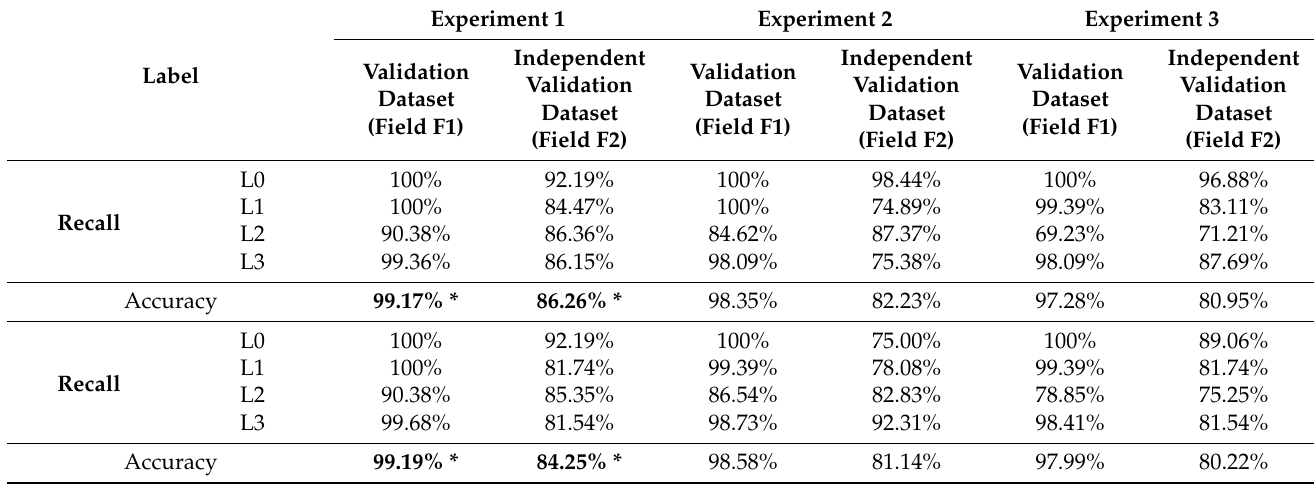
Figure 6. Architecture of CNNs used for experiments 2 ( a ) and 3 ( b ). Table 10. Classification results of three experiments with 5 × 5 and 7 × 7